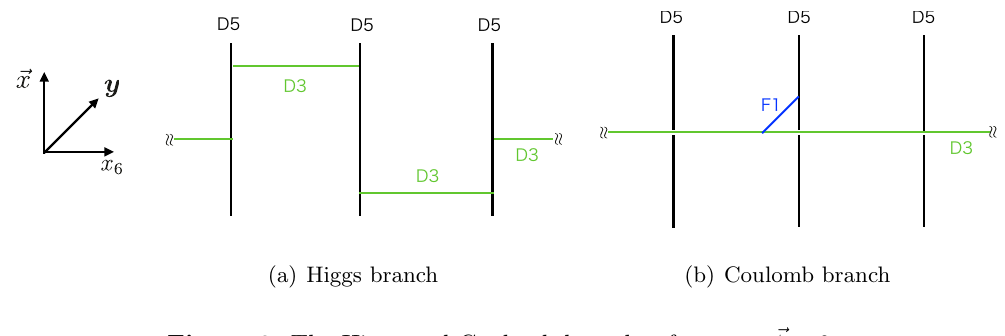
Figure 9 . The Higgs and Coulomb branches for m